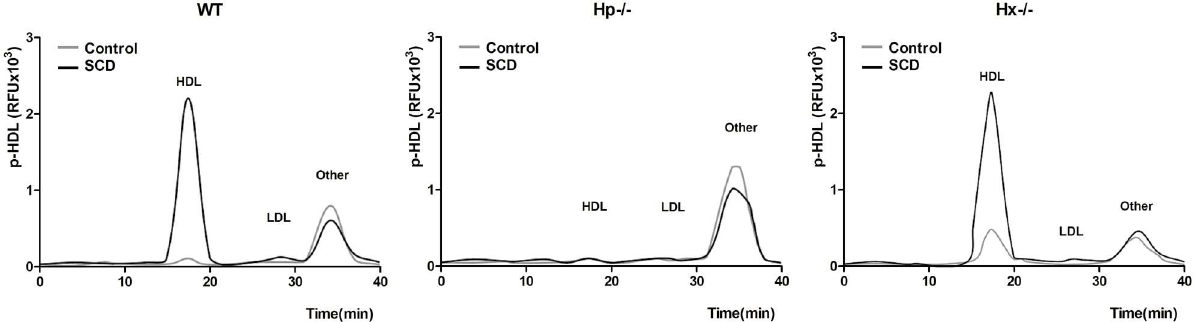
Fig 6. Hemopexin (Hp) is required to increase levels of p-HDL in SCD. The lipoprotein fractions were isolated by HPLC assay to detect p-HDL (accumulationof ROS) in wild-type (WT), Hp − / − and Hx − / − mice. A significantlylower level of p-HDL is seen in SCD mice with Hp knock-out, compared with other SCD groups, confirming that Hp is the protein necessary for the proinflammatory properties of HDL. (Other = other fractions of lipoprotein; RFU, relative fluorescence units).